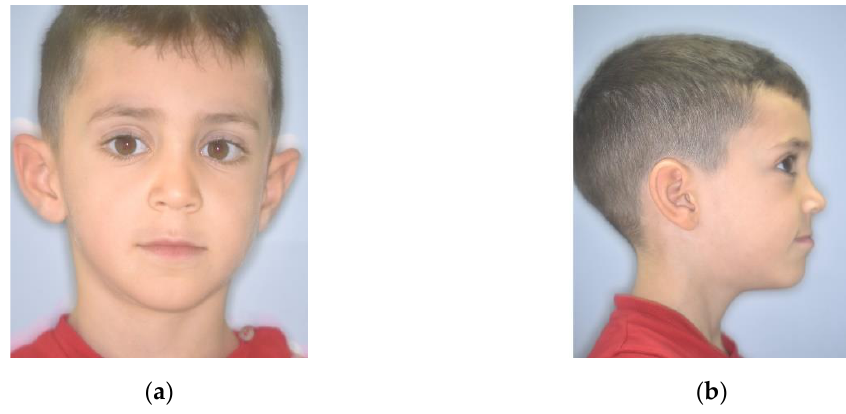
Figure 1. Extraoral pretreatment pictures: ( a ) frontal view; ( b ) lateral